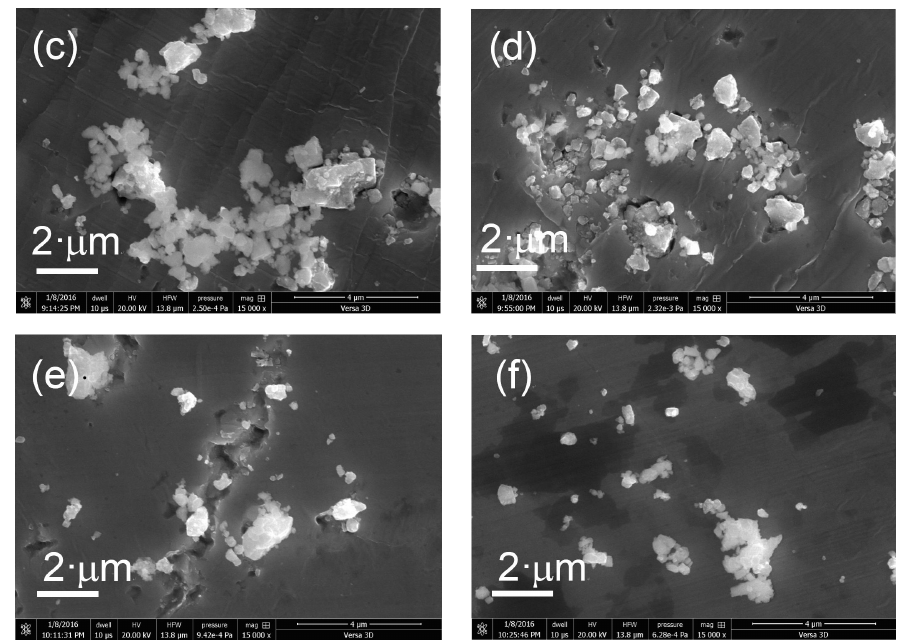
Figure 4. SEM images of Pt/KTa(Zr)O 3 modified with ( a ) Dye 1 , ( b ) Dye 2 , ( c ) Dye 3 , ( d ) Dye 4 , ( e ) Dye 5 and ( f ) Dye 6 .